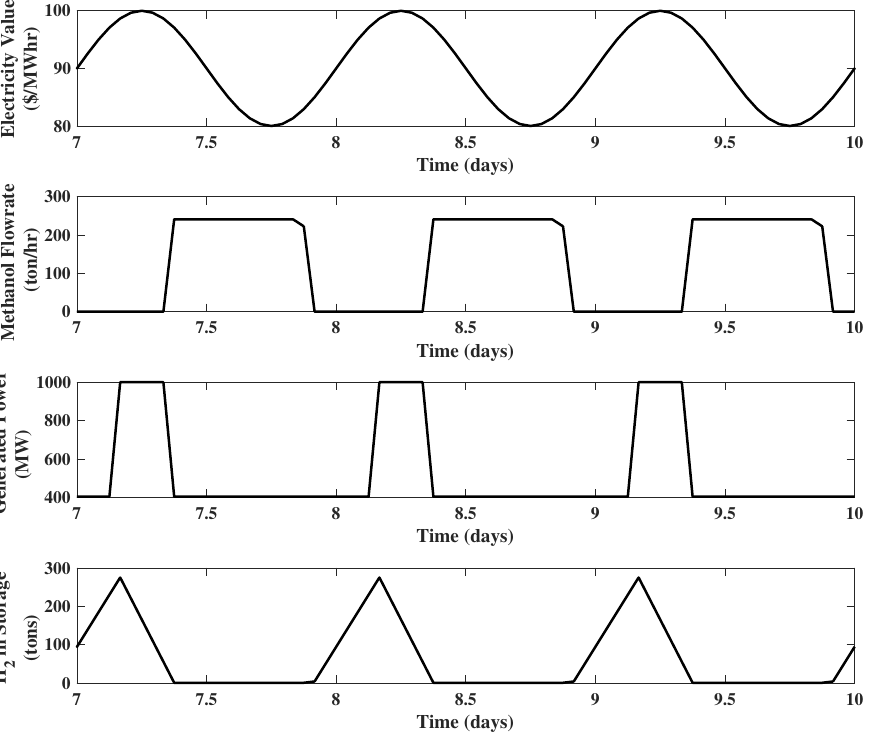
Figure 6. Closed-loop simulation of EMPC using a 24 h prediction horizon for the case of c M = 110 $/ton MeOH for Example